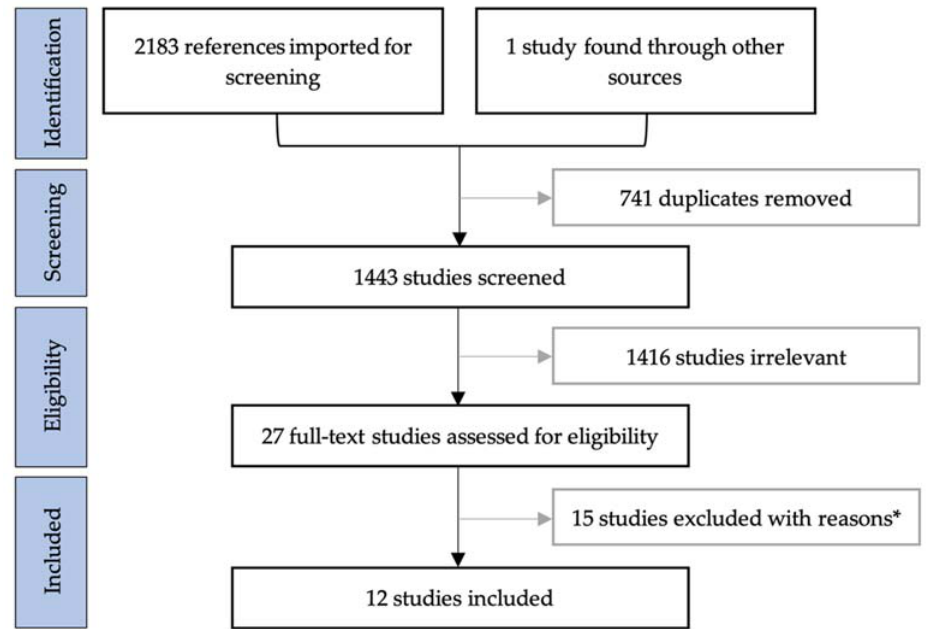
Figure 1. Flow chart of the literature search following Preferred Reporting Items for Systematic Reviews and Meta-Analyses (PRISMA) guidelines. * Reasons for exclusions after full-text assessment provided in Appendix A.